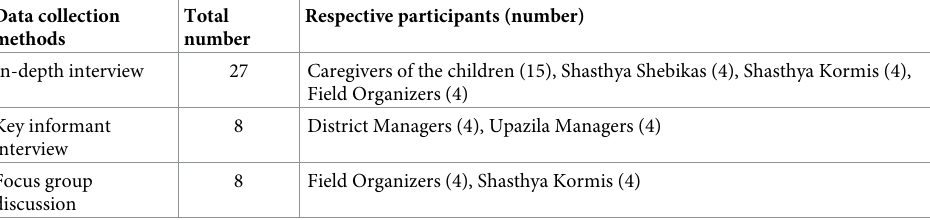
Table 1. Number of IDIs, KIIs and FGDs conducted among the respective